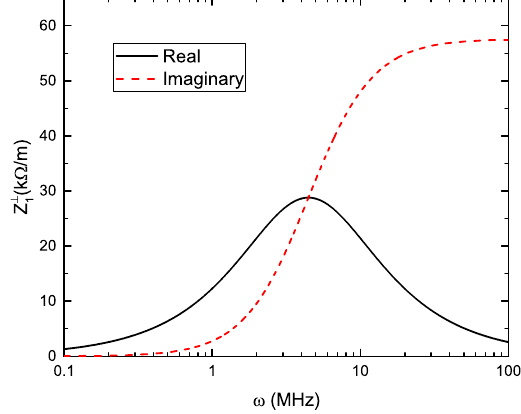
FIG. 2. The transverse kicker impedance changes over angular